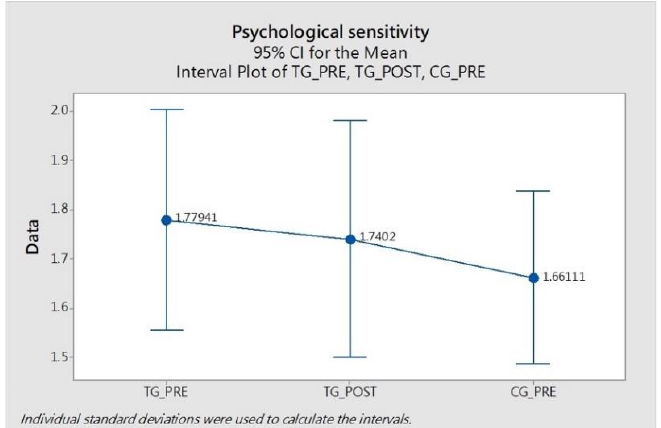
Figure 11. Interval plot for Psychological sensitivity of TG_PRE, TG_POST, and CG.